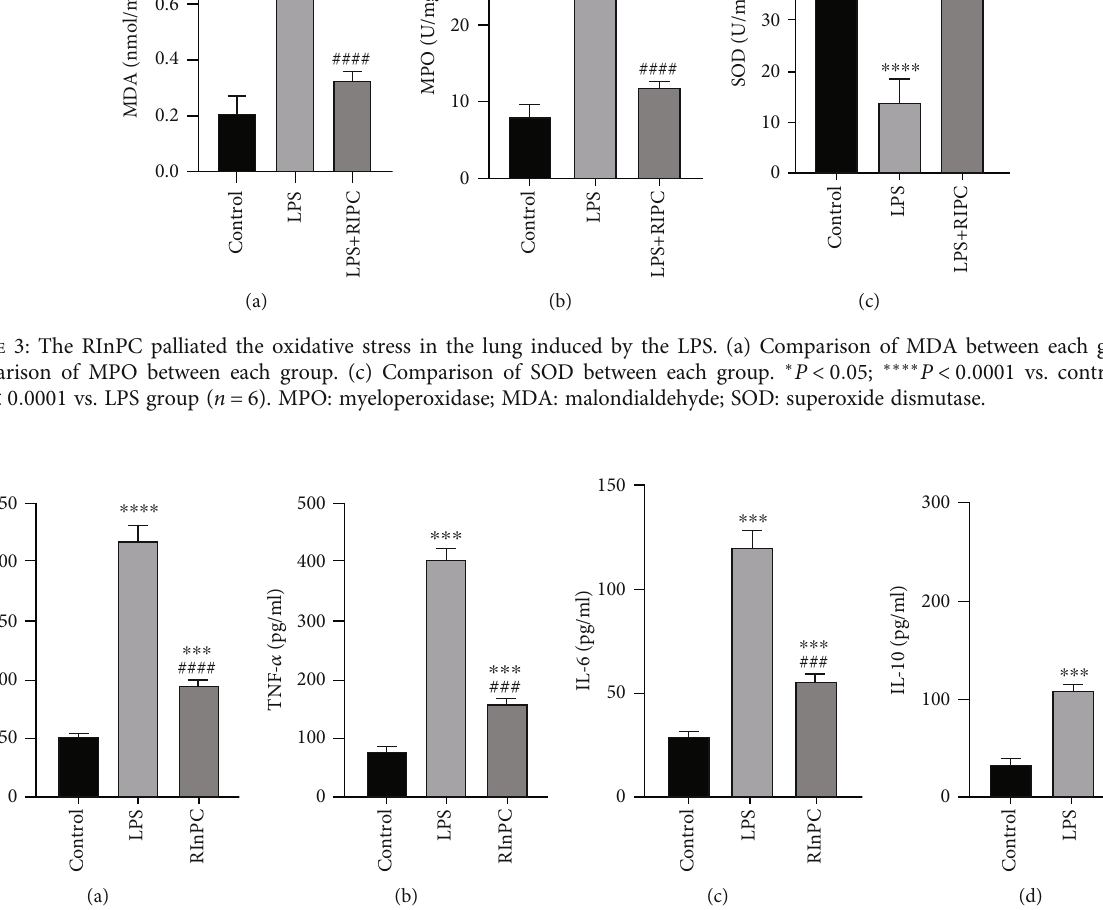
Figure 4: The RInPC reduced proin fl ammatory cytokine secretion induced by the LPS. (a) Comparison of TNF- α between each group. (b) Comparison of IL-1 β between each group. (c) Comparison of IL-6 between each group. (d) Comparison of IL-10 between each group. ∗∗∗ P < 0 : 001 ; ∗∗∗∗ P < 0 : 0001 vs. control group; ### P < 0 : 001 ; #### P < 0 : 0001 vs. LPS group ( n = 6 ). TNF- α : tumor necrosis factor-alpha; IL-1 β : interleukin-1 β ; IL-6: interleukin-6; IL-10: